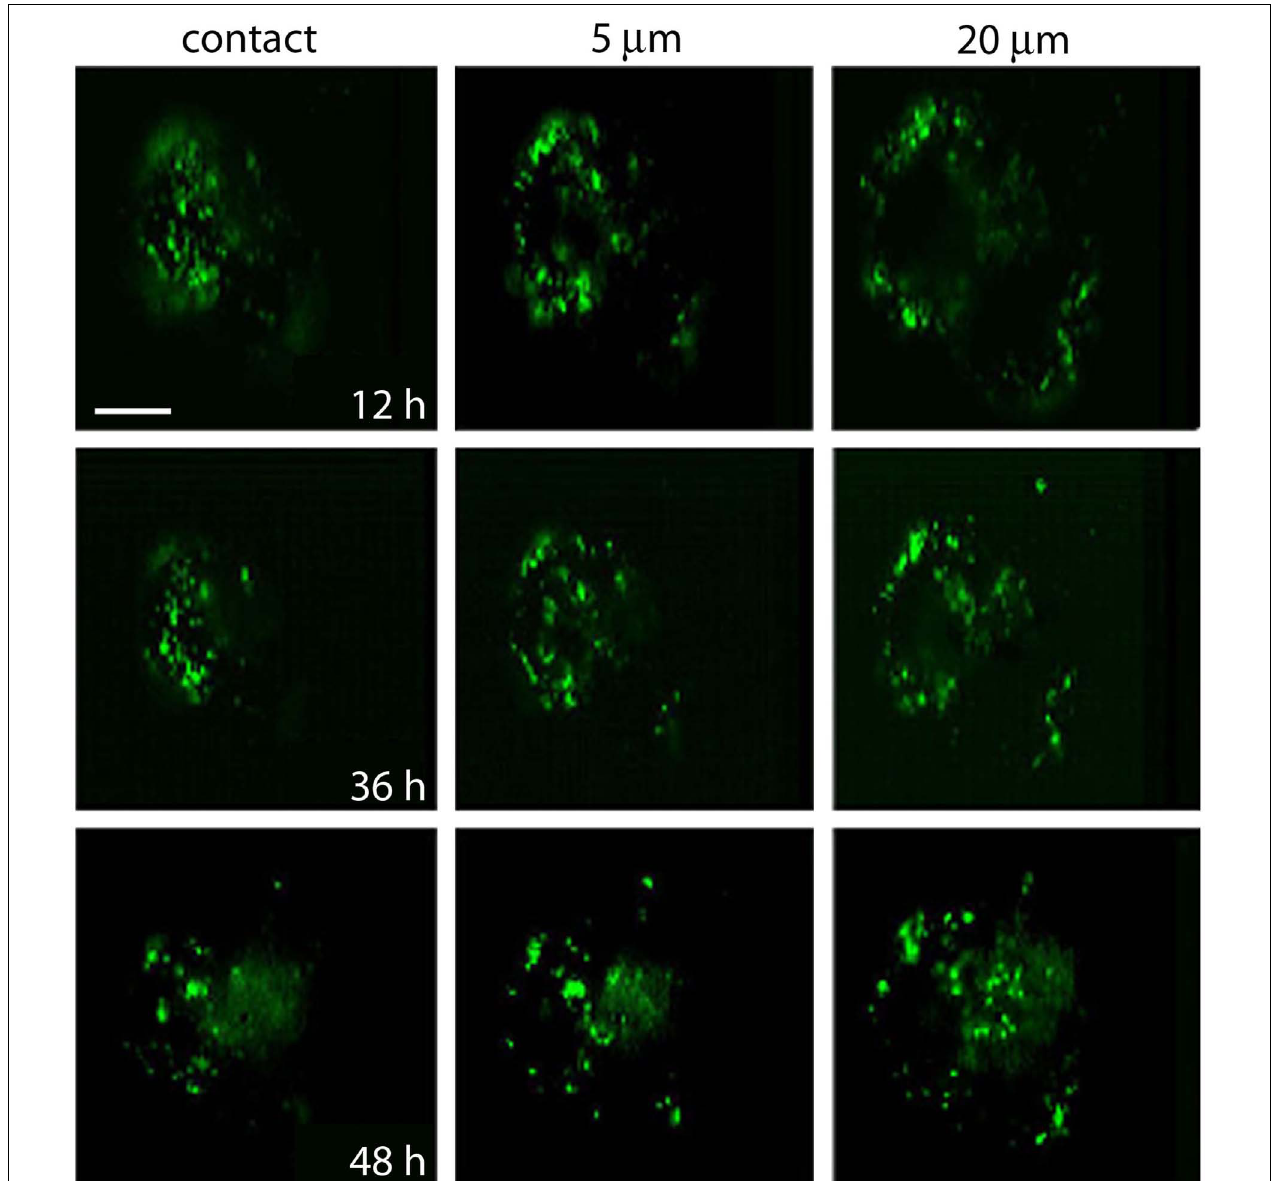
FIGURE 7 | Migration of fluorescent FM1-43 spots. Images taken from the site of contact with the dish bottom (left) and at 5 and 20 μ m depth. Each area was imaged at 12, 36, and 48h after depolarization of cultured neurons in